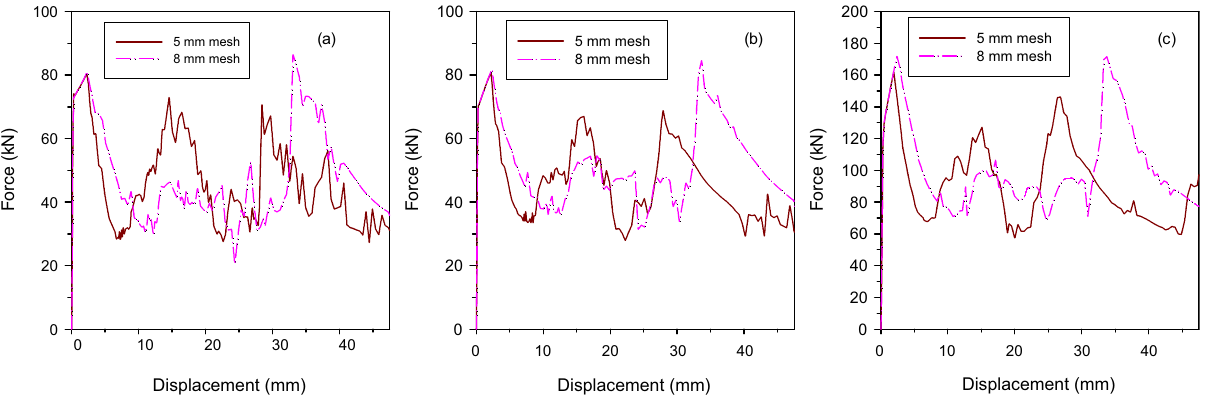
Figure 22: Force versus displacement curve with two di ff erent mesh sizes and three di ff erent steel materials. ( a ) Mild steel, ( b ) SAE 1008 steel, and ( c ) SAE 1045